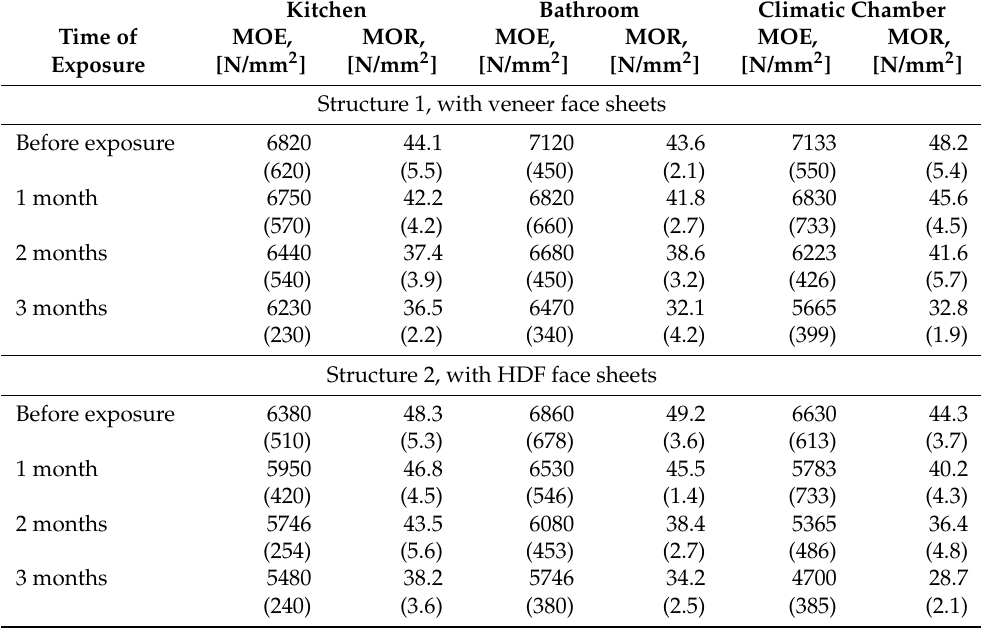
Table 6. Mechanical properties of the blockboards exposed in different climate conditions (average values). Kitchen Bathroom Climatic